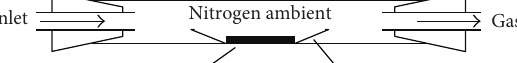
Transparent camphoric-CNT